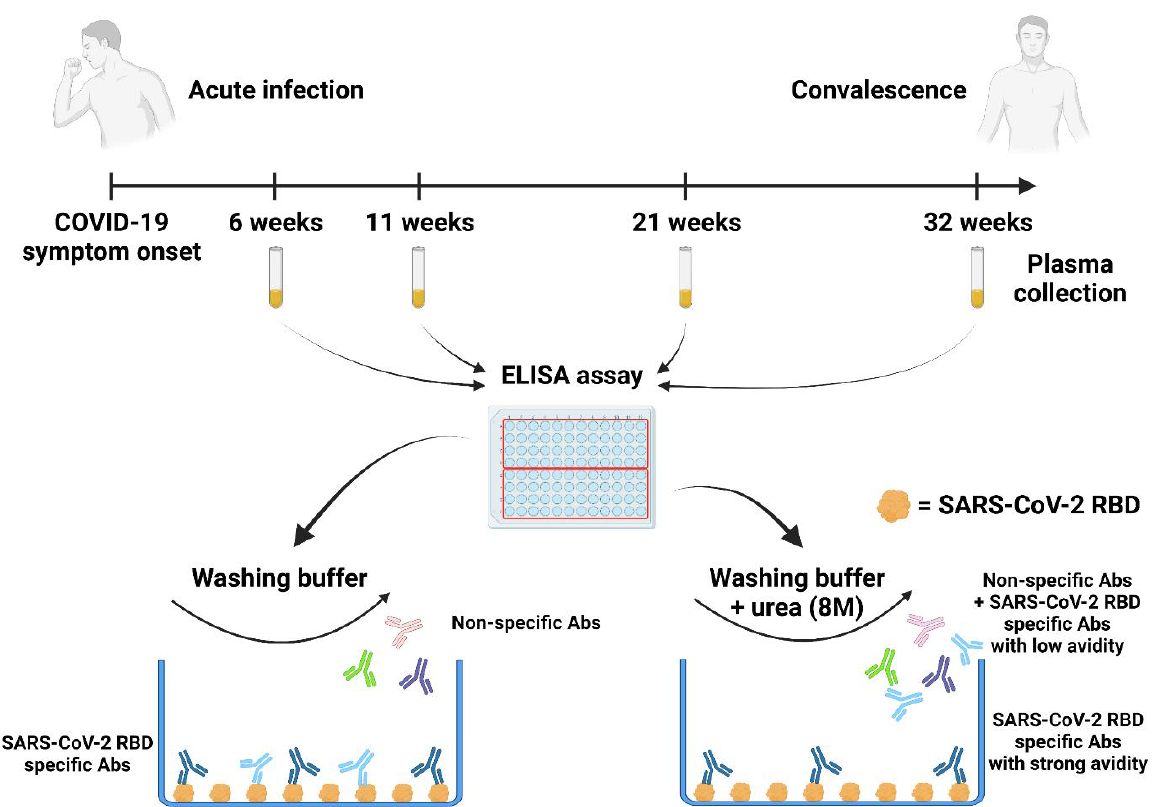
Figure 1. RBD avidity assay . Plasma samples were collected from a cohort of 29 COVID-19 recovered donors at 6, 11, 21, and 32 weeks PSO. 96-well ELISA plates were coated with SARS-CoV-2 S RBD proteins and incubated with plasma samples. Then, wells were washed with an ELISA buffer or an ELISA buffer supplemented with urea (8M). Created with BioRender.com.